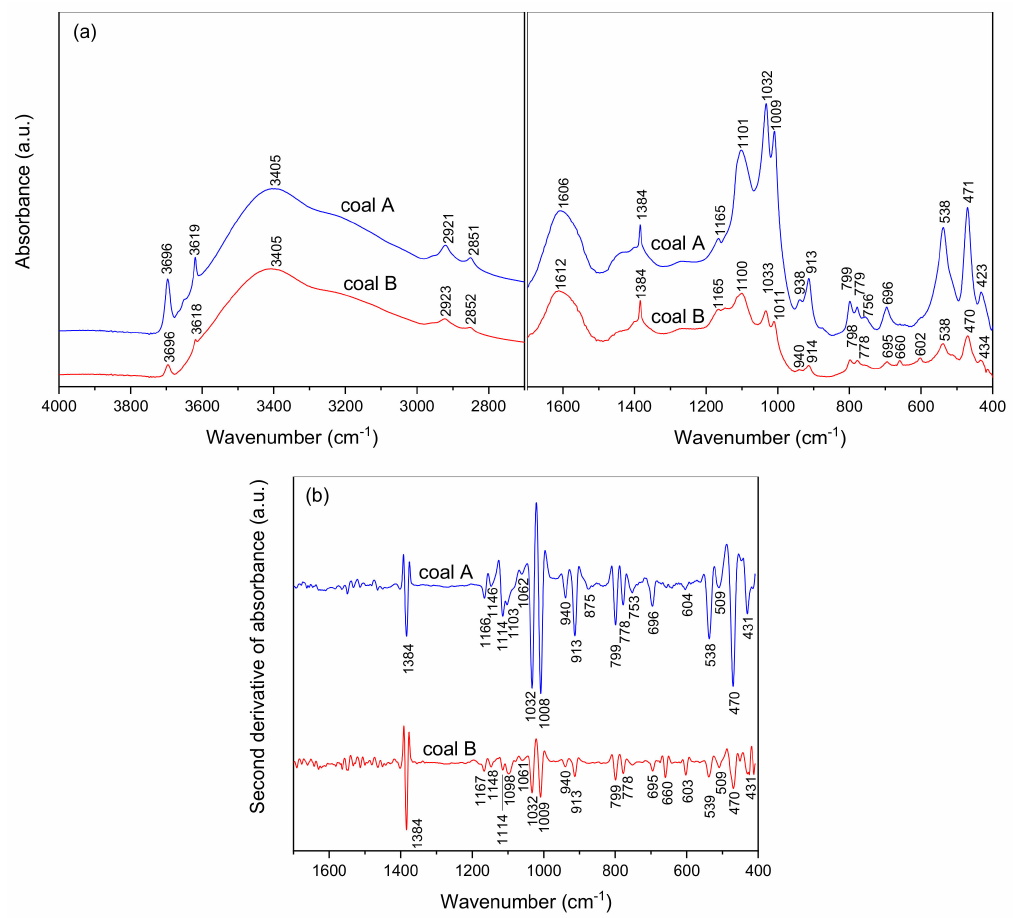
Figure 1. FTIR spectra of coals: ( a ) Original spectra and ( b ) second-derivative